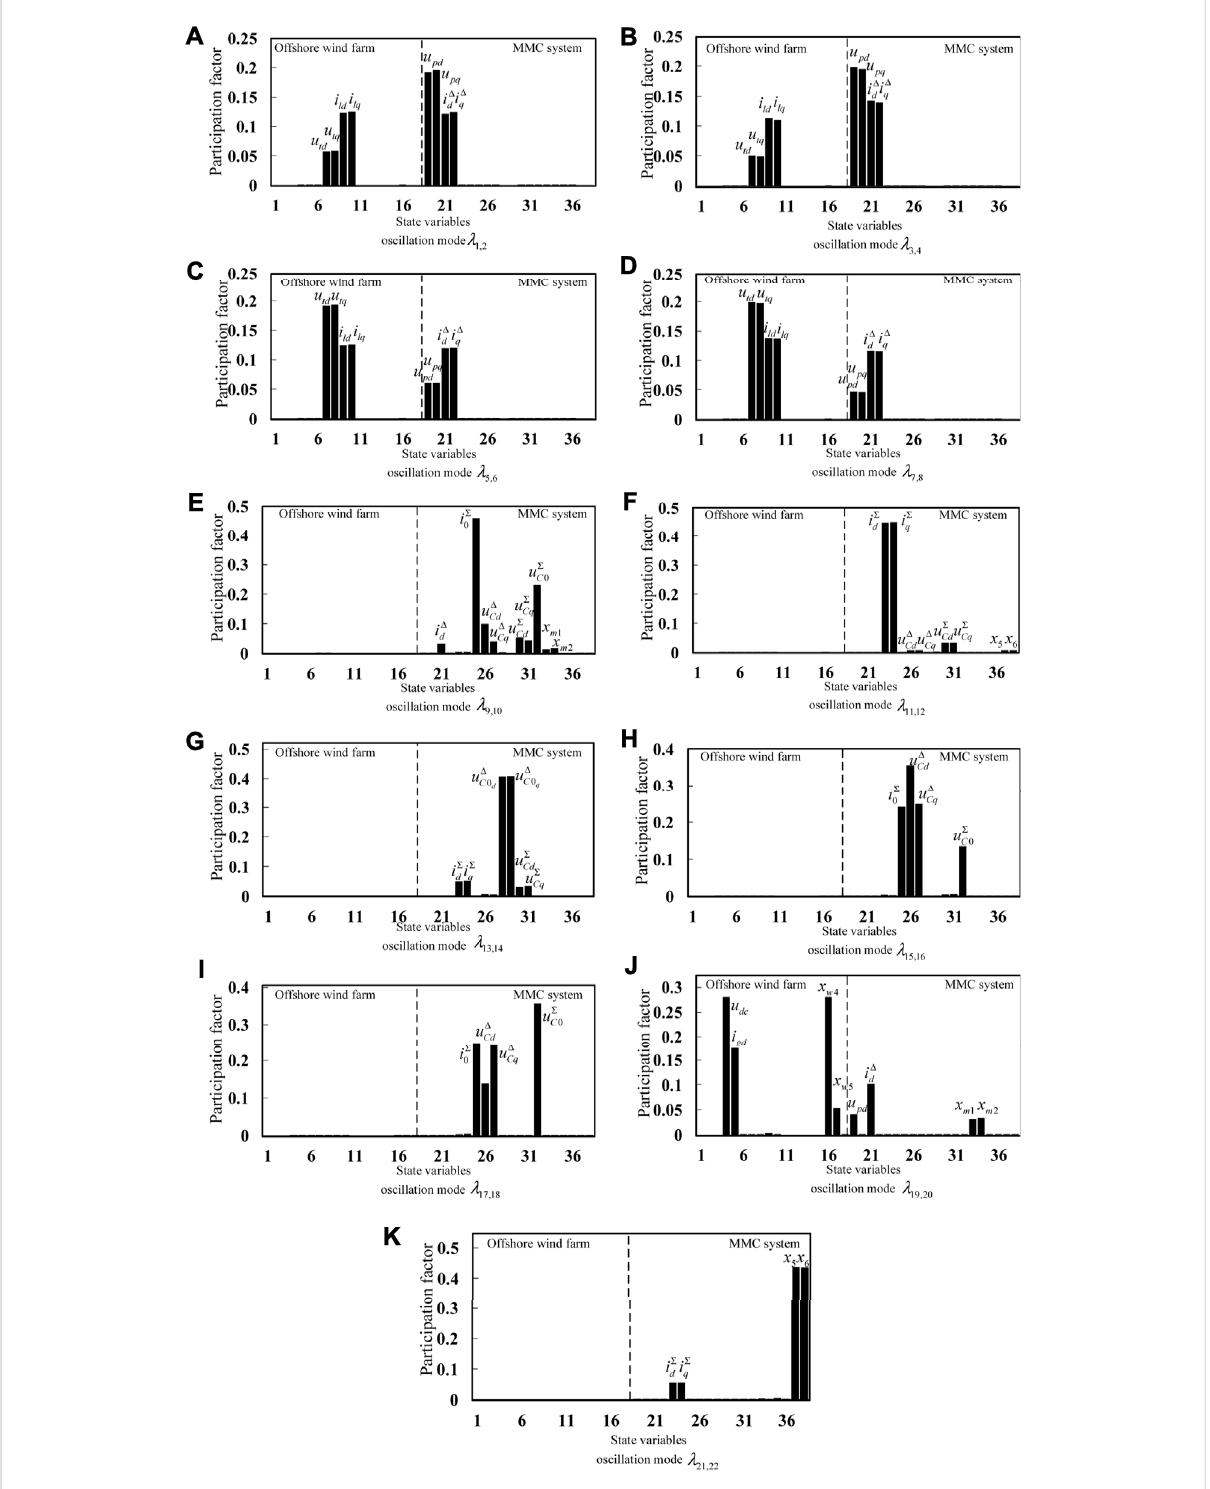
FIGURE 2 Participation factors of 11 oscillation modes of the system. The part label (A – K) is used for the distinction between results of 11 oscillation modes, there is no additional description